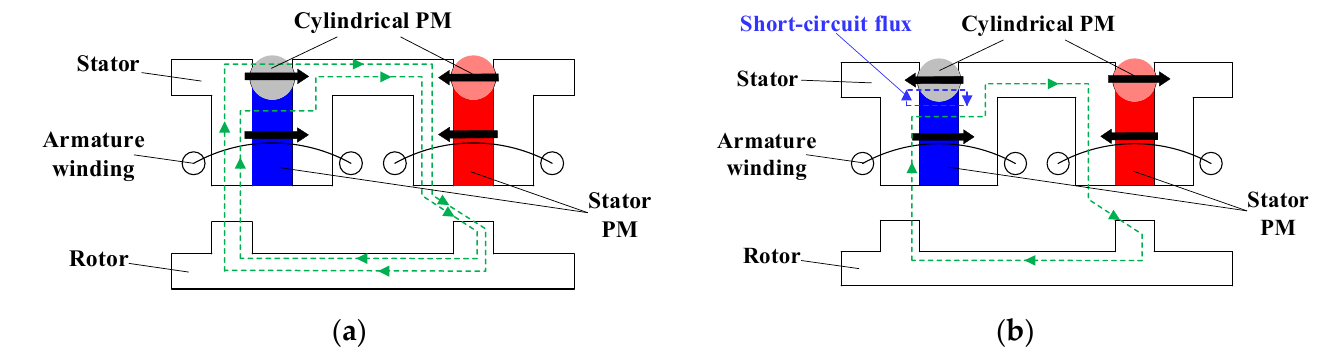
Figure 17. Illustration of operating principle of the stator-PM MR machine with cylindrical PMs [62].